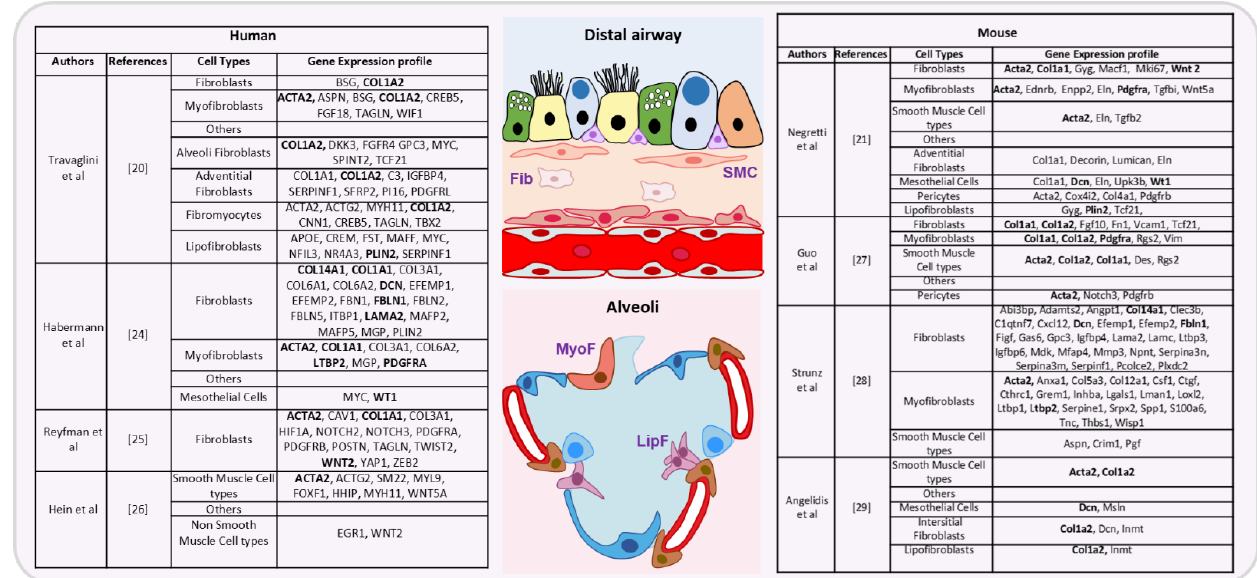
Figure 1. Summary of genes expressed in the different lung mesenchymal cell types (distal airways and alveoli), based on different recent studies in human ( left ) [20,24–26] and mouse ( right ) [21,27–29] samples. For fibroblasts cells (Fib), smooth muscle cell types (SMC), myofibroblasts (MyoF) and lipofibroblasts (LipF), genes present in at least two different studies are listed in bold. Distal airway: goblets, ciliated, club and basal cells are green, yellow, blue and lila, respectively. Alveoli: alveolar type 1, alveolar type 2 and pericytes are dark blue, light blue and brown, respectively.